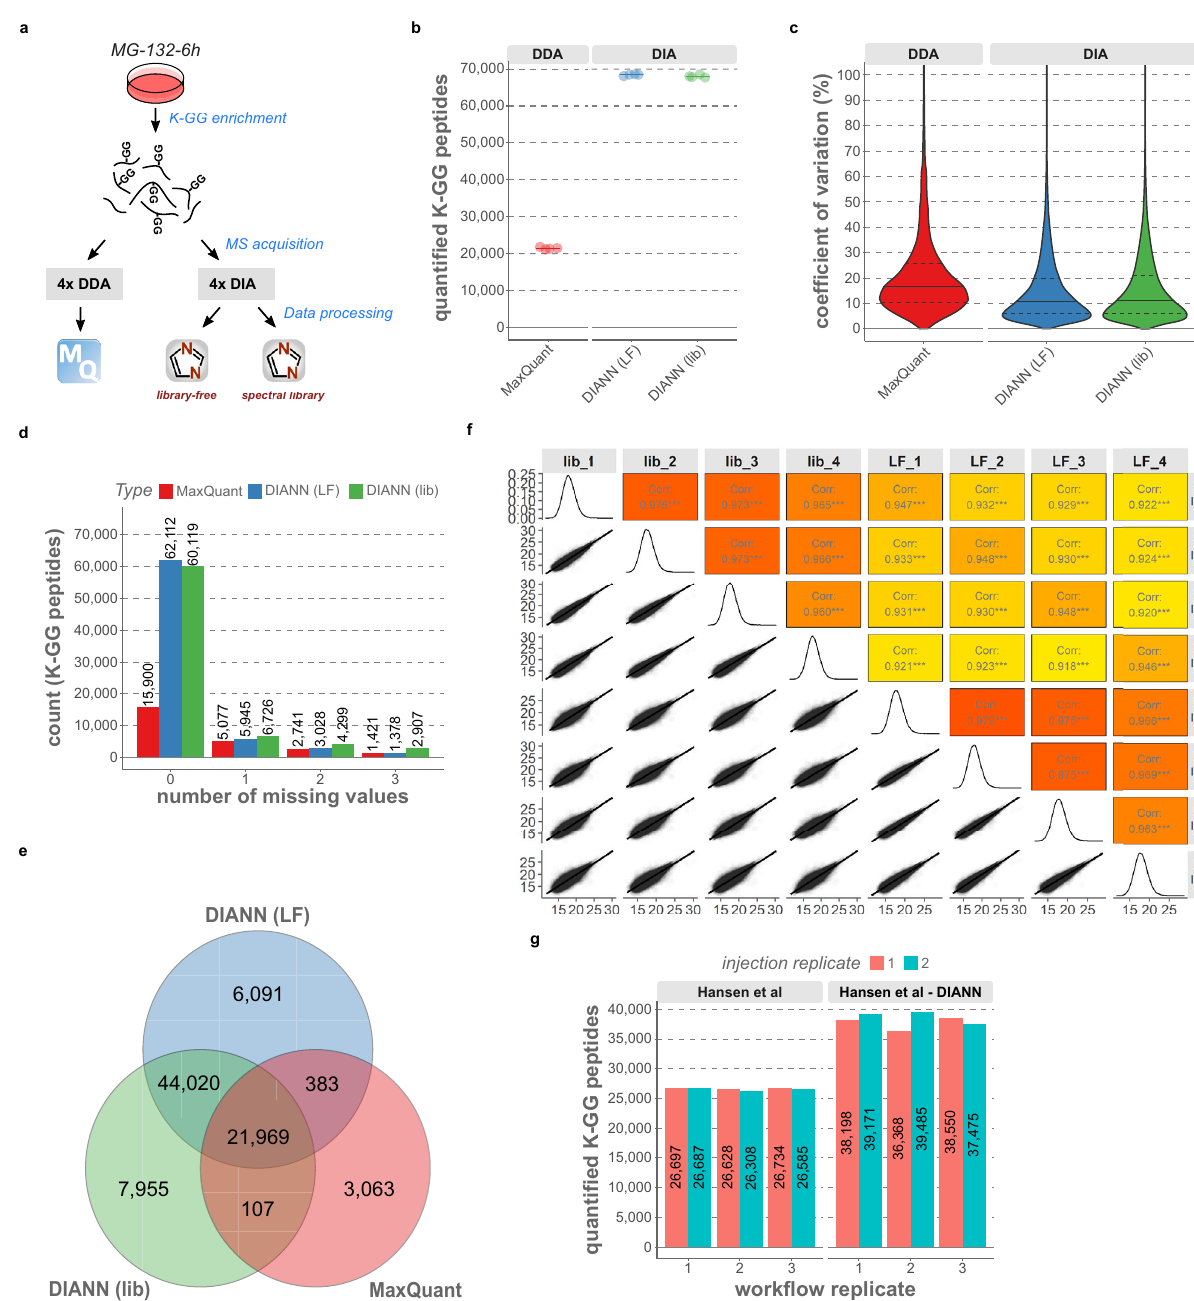
Fig. 2 Side-by-side comparison of DDA and DIA for ubiquitinomics. a Schematic of data-dependent acquisition (DDA) and data-independent acquisition (DIA) strategies. A K-GG peptide sample was prepared from MG-132-treated HCT116 cells and four replicates were acquired with each scan mode. The DDA data were processed with MaxQuant (MBR enabled). For DIA data processing in DIA-NN, the same DIA-MS raw fi les were processed with either library-free (no experimental spectral library) or library-based search (experimental spectral library obtained through high pH reversed-phase fractionation of peptides prior to K-GG peptide enrichment). b Quanti fi ed K-GG peptides with 2 mg of total protein as input for each replicate, in a side-by-side comparison of DDA and DIA-MS. Four samples (injection replicates) were acquired with 75 min single-shot LC-MS runs and processed with MaxQuant or DIA-NN. Library-based DIA data analysis was performed with an ultra-deep K-GG peptide library generated by library-free DIA analysis of high-pH fractions, as detailed in “ Methods ” (LF = library-free, lib = experimentally-generated spectral library). c Coef fi cients of variation (CVs, in %) for K-GG peptides as shown in b are plotted for each method. Continuous lines demarcate the median and dashed lines the upper and lower quartiles. d Number of identi fi cations with 0, 1, 2, or 3 missing values in four replicates (samples shown in b ) for DDA and DIA. e Venn diagram showing overlap of ubiquitinated peptides (K-GG) identi fi ed by DDA and by DIA (DIA-NN ’ s library-free (LF) and spectral library-based (lib) approaches). f Scatter plot of Log2- transformed K-GG peptide intensities obtained from library-free and spectral library-based search options in DIA-NN (n = 4, injection replicates). Values indicate Pearson correlation coef fi cients. g Raw data of MG-132-treated HEK293 cells from Hansen et al. (Fig. 1d in the original manuscript, three work fl ow replicates, each injected in duplicate and processed with Spectronaut ’ s directDIA mode 16 ) were processed with DIA-NN (library-free mode). Plots show identi fi ed K-GG peptides (unique peptide sequences) for both Software packages. Source data are provided as a Source Data fi